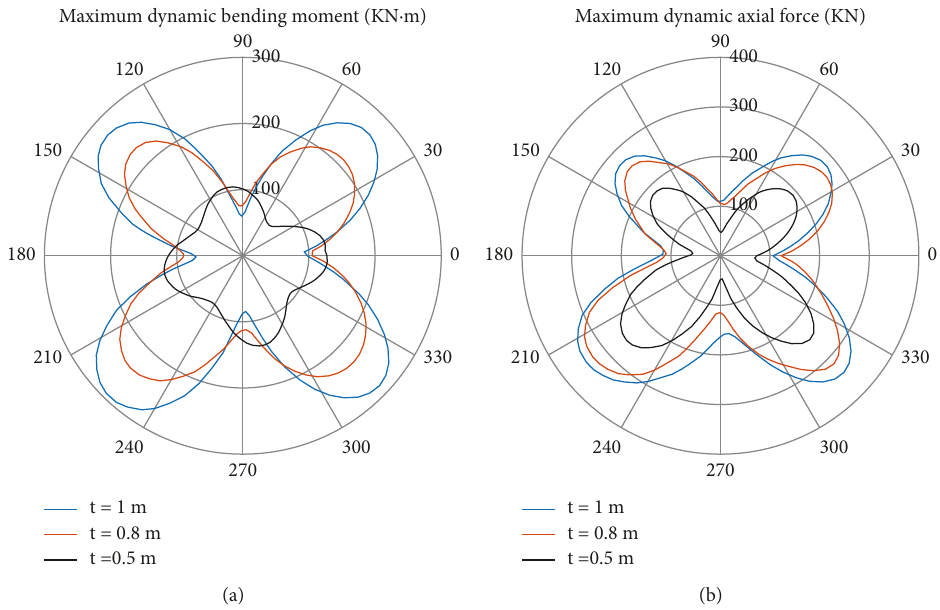
Figure 7: (a) Maximum dynamic bending moment at different positions under different lining thicknesses. (b) Maximum dynamic axial force at different positions under different lining thicknesses.